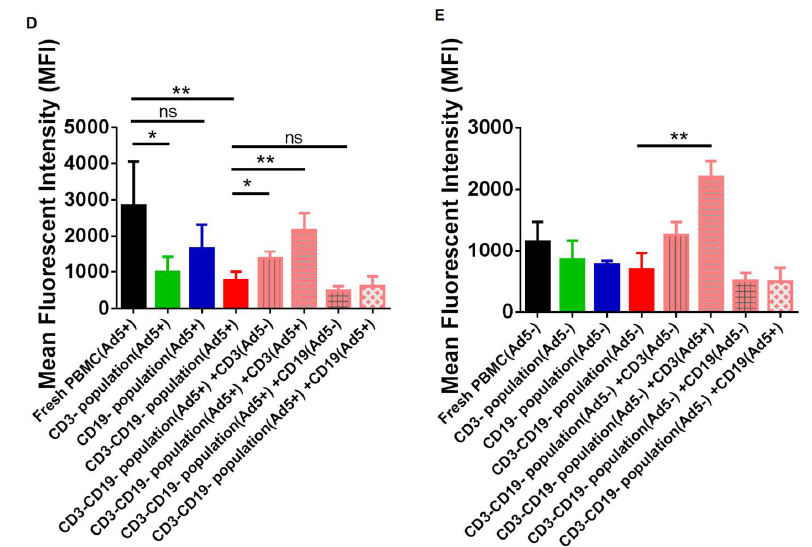
Figure 3. The efficacy of adenovirus infection into CD14+ monocytes was significantly affected by removing or adding CD3+ T lymphocytes from PBMC samples of Ad-seropositive individuals. Different cell populations were magnetically sorted from human PBMCs as described in methods, and then infected with 1250vp/cell of Ad5-EGFP. After incubation for 24 h, the efficacy of Ad infection was detected. ( A ) Representative graphics of FACS analysis and gating strategy to determine the purity of sorted cell populations. ( B ) Percentage of EGFP positive cells in CD14+ monocytes from Ad5-seropositive samples ( n = 3) under different treatments, including fresh PBMCs, CD3-depleted PBMCs [CD3- population (Ad5+)], CD19-depleted PBMCs [CD19- population(Ad5+)], CD3-/CD19- double depleted PBMCs [CD3-CD19- population], CD3-/CD19- double depleted PBMCs but suppled with CD3+T cells from Ad5-seronegative subjects [CD3-CD19- population(Ad5+)+CD3(Ad5-)], CD3-/CD19- double depleted PBMCs but suppled with CD3+T cells from Ad5-seropositive subjects [CD3-CD19- population(Ad5+)+CD3(Ad5+)], CD3-/CD19- double depleted PBMCs but suppled with CD19+ B cells from Ad5-seronegative subjects [CD3-CD19- population(Ad5+)+CD19(Ad5-)], and CD3-/CD19- double depleted PBMCs but suppled with CD19+ B cells from Ad5-seropositive subjects [CD3-CD19- population(Ad5+)+CD19(Ad5+)]. ( C ) Percentage of EGFP positive cells in CD14+ monocytes from Ad5-seronegative samples ( n = 3) under different treatments as descripted above. ( D ) Expression level of EGFP protein (represented with MFI value) in CD14+ monocytes from Ad-seropositive subjects ( n = 3) as descripted above. ( E ) Expression level of EGFP protein (represented with MFI value) in CD14+ monocytes from Ad-seronegative subjects ( n = 3) as descripted above. The bars represent the standard error. *: p < 0.05, **: p < 0.01, ns: no